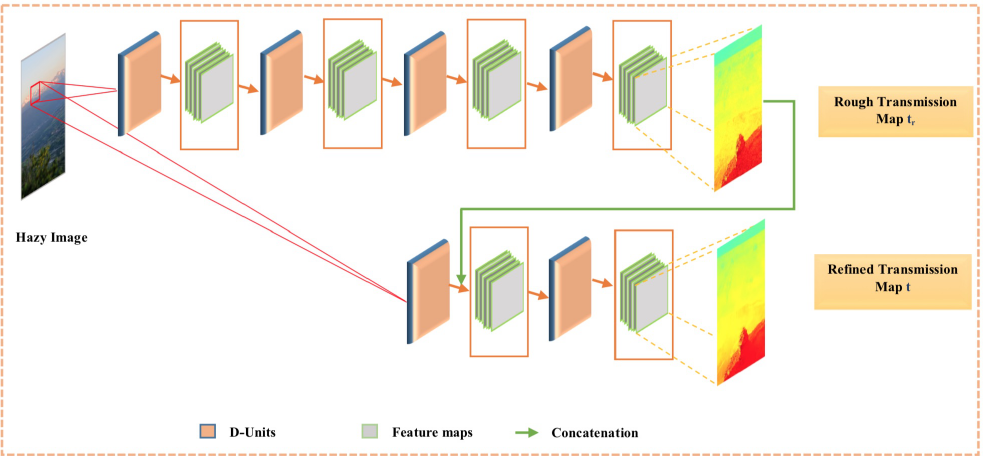
Figure 7. General proposed architecture CMT net